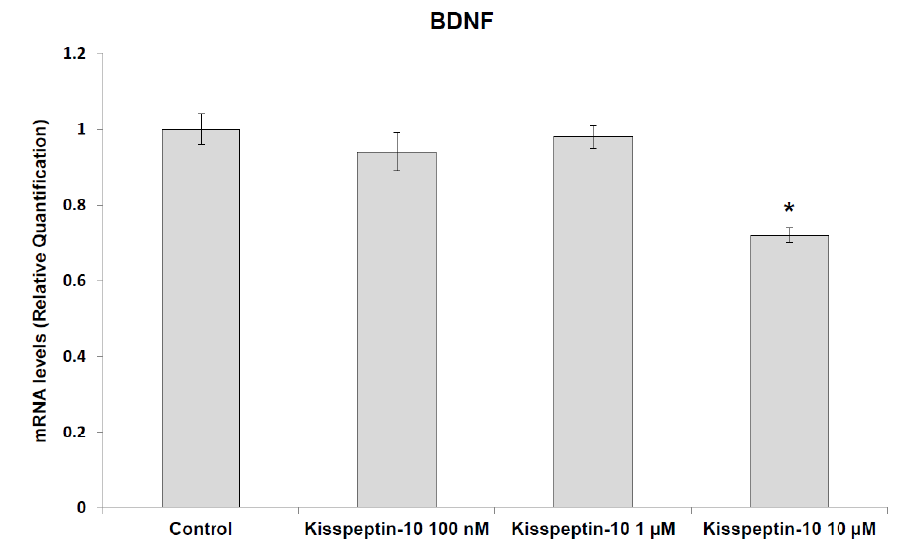
Figure 2. Effect of kisspeptin-10 (100 nM–10 µ M) treatment on relative gene expression of brain-derived neurotrophic factor (BDNF), as determined by real-time RT PCR in rat hypothalamic (Hypo-E22) cell line ( n = 5 individual culture flasks for each condition). Data were calculated using the 2 − ∆∆ Ct method; they were normalized to β -actin mRNA levels and then expressed as relative to vehicle. Compared to control, kisspeptin-10 treatment significantly decreased BDNF (ANOVA, p < 0.01; post-hoc, * p < 0.05 vs. control) gene expression.